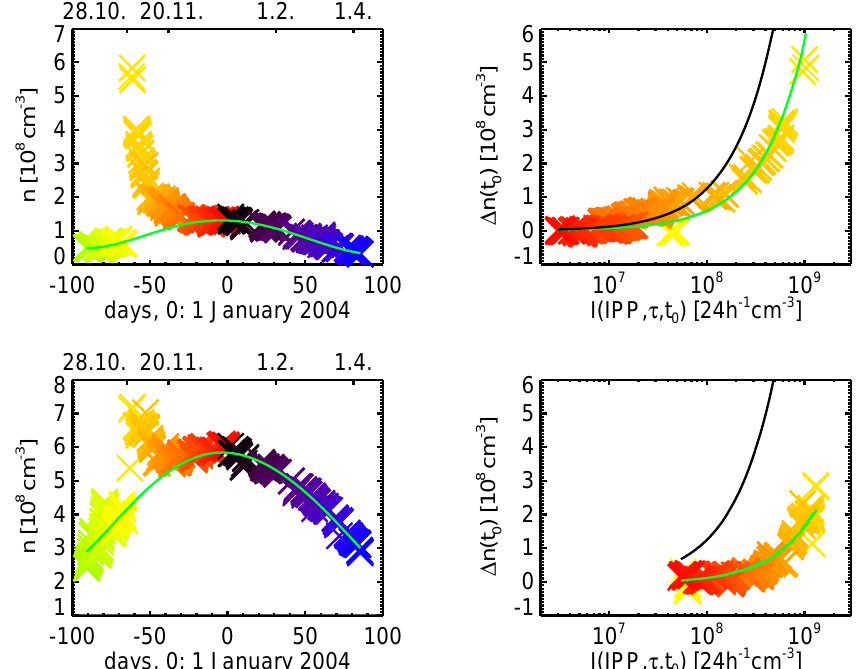
Fig. 3. Left: time curve of the number density n of NO x at a geomagnetic latitudes between 50 ◦ S and 90 ◦ S, and at altitudes of 56km (top) and 45km (bottom) in the Austral summer 2003/04. The colour code of the crosses is time dependent: at days before the SPE, the crosses are green and yellow. During the SPE they are orange and merge to red until the end of December. Days in 2004 are dark (black to blue). The green curve is a fitted polynomial function and shows the background number density n( IPP = 0 ) . Right: 1n MIPAS (the difference of the number density and the correspondent value of the fitted function at the plot left) is plotted in dependence of I( IPP ,τ,t 0 ) , specified in Eq. (7), at geomagnetic latitudes between 50 ◦ S and 90 ◦ S, and at altitudes of 56km (top) and 45km (bottom). The colour code is the same as in the left panel. The green curve is a linear fit. The black curve shows the theoretical function for a production rate of 1.25 N per ion pair. The standard error of the mean of the number densities is always lower than 1%, besides the days during the SPE (lower than 5%).